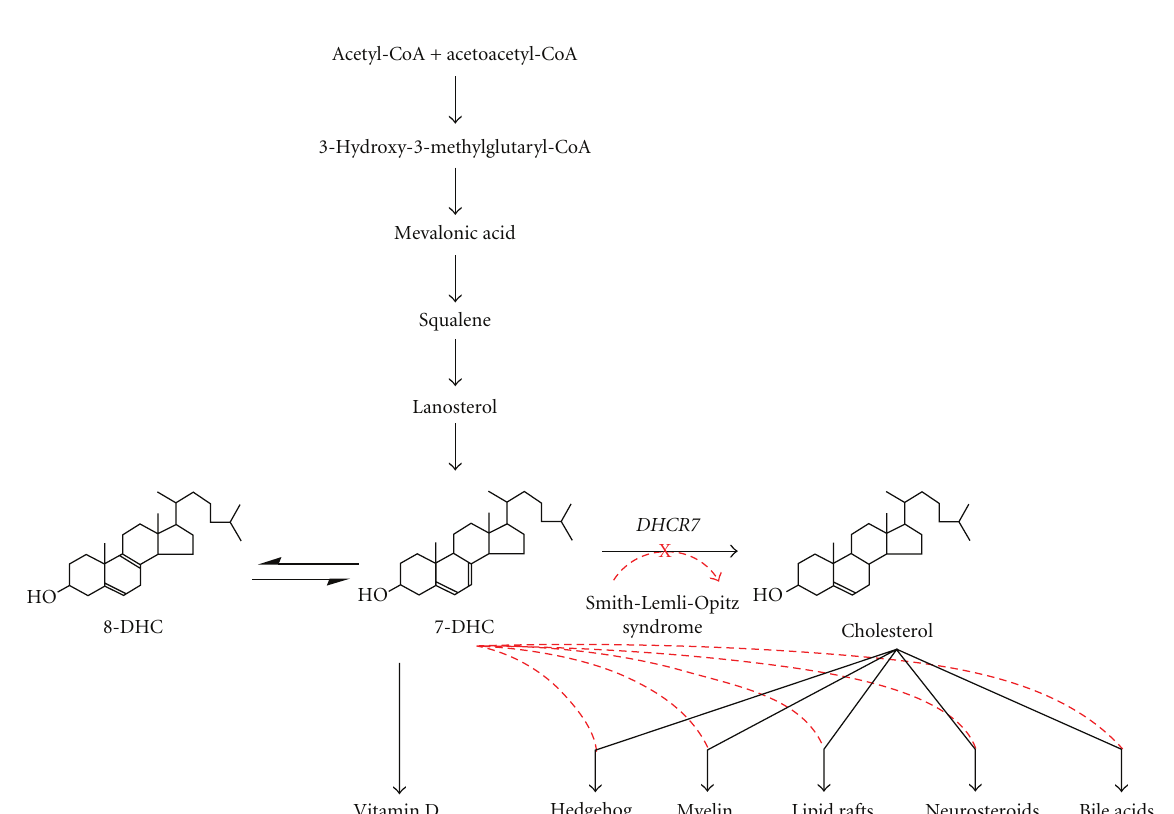
Figure 1: E ff ect of sterol precursor substitution in Smith-Lemli-Opitz syndrome. (Adapted with permission from Richard Kelley, M.D. and Forbes Porter,